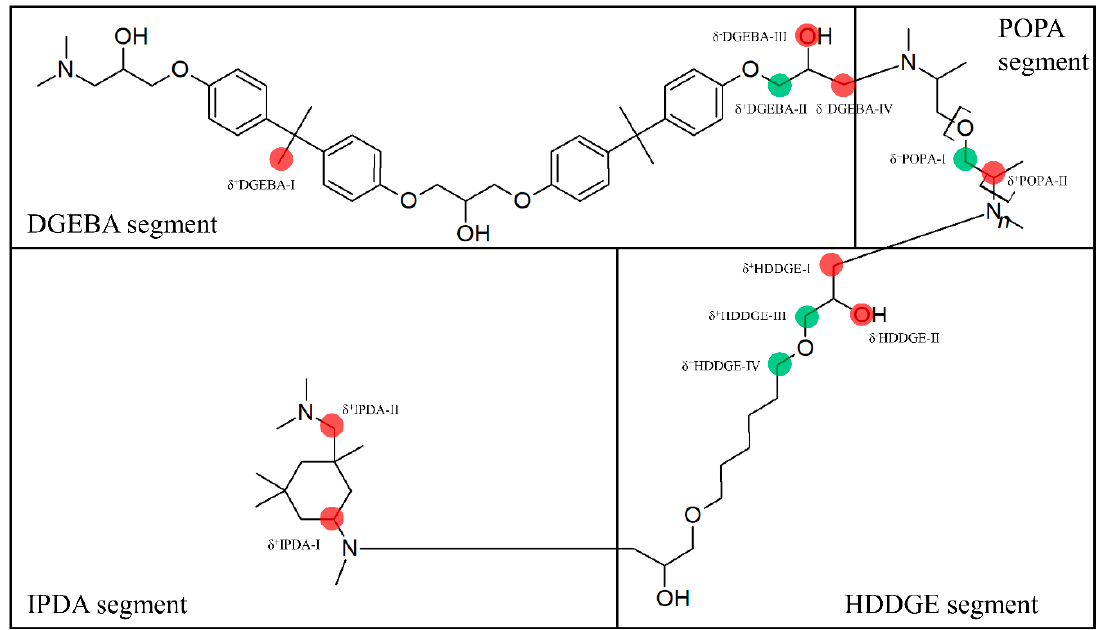
Figure 10. Chemical structure of the studied DGEBA/HDDGE/IPDA/POPA amine epoxy network (mixing ratios are not considered). Marked sites represent “weak points” for radical attack in the network. Sites marked in red are excluded based on experimental evidence and literature. Sites marked in green are the main reactive sites.